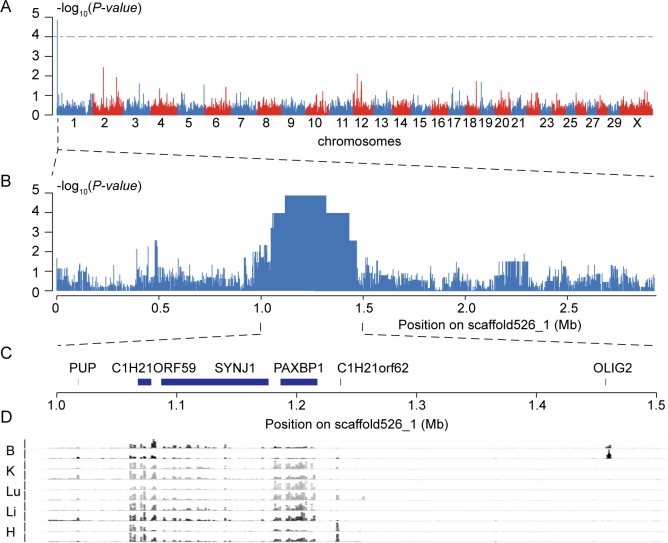
Associated mapping of the polled phenotype.(A) Genome-wide P values (y axis) are plotted along the genome (B) and magnification of scaffold526_1. (C) All genes around the candidate GWAS region. (D) diagram of read depths (X axes) of RNA-seq data mapping of five different tissues: brain (B), kidney (K), lung (Lu), liver (Li) and heart (H), each with two replicates (Y axes).